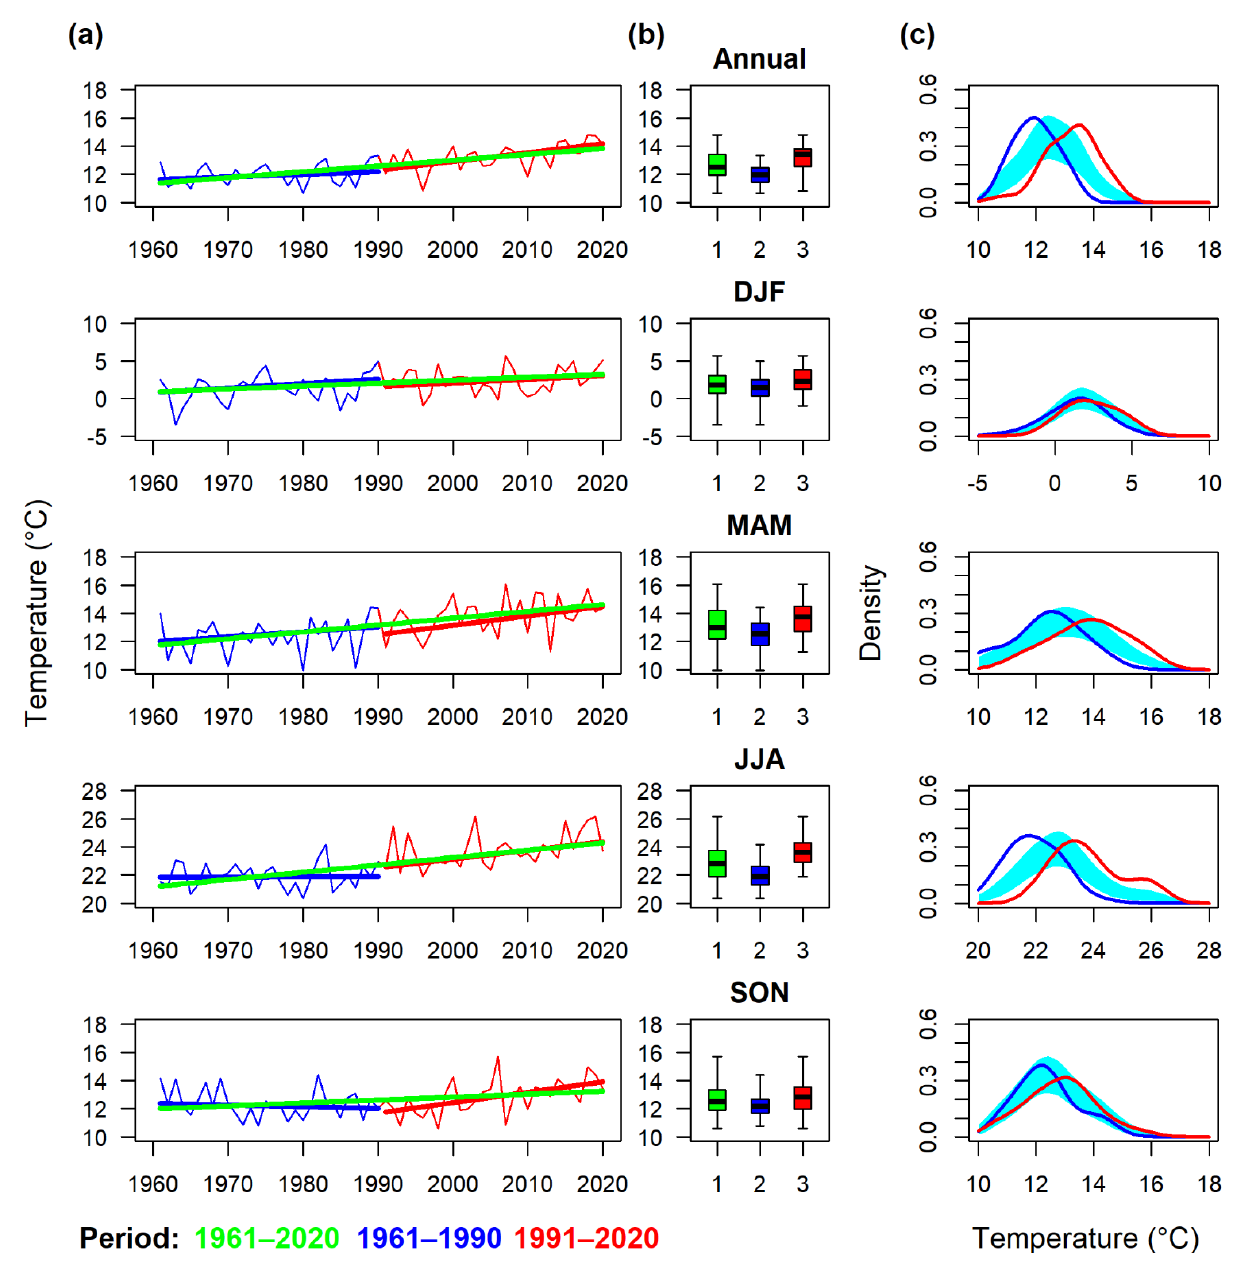
Figure 7. Annual and seasonal mean maximum temperature series for the territory of the Czech Republic in the 1961 – 2020 period: ( a ) fluctuations with linear trends in the entire period, 1961 – 1990 and 1991 – 2020; ( b ) box plots (median, lower and upper quartile, minimum, and maximum) for 1961 – 2020 (1), 1961 – 1990 (2), and 1991 – 2020 (3); ( c ) the density distribution of the series in 1961 – 1990 and 1991 – 2020. The density curves outside the reference band (green – blue) indicate a significant difference in the two distributions (and vice versa).